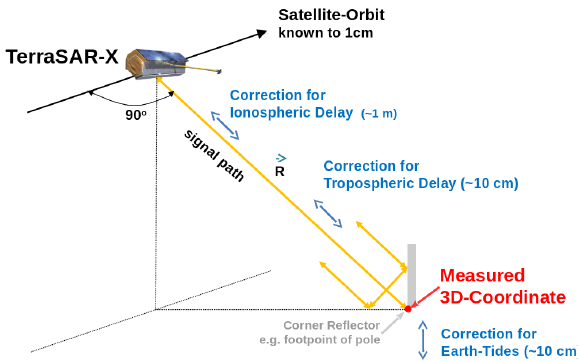
Figure 1. Measurement of a pole footpoint by a SAR satellite and geodetic correction of the absolute position to a few